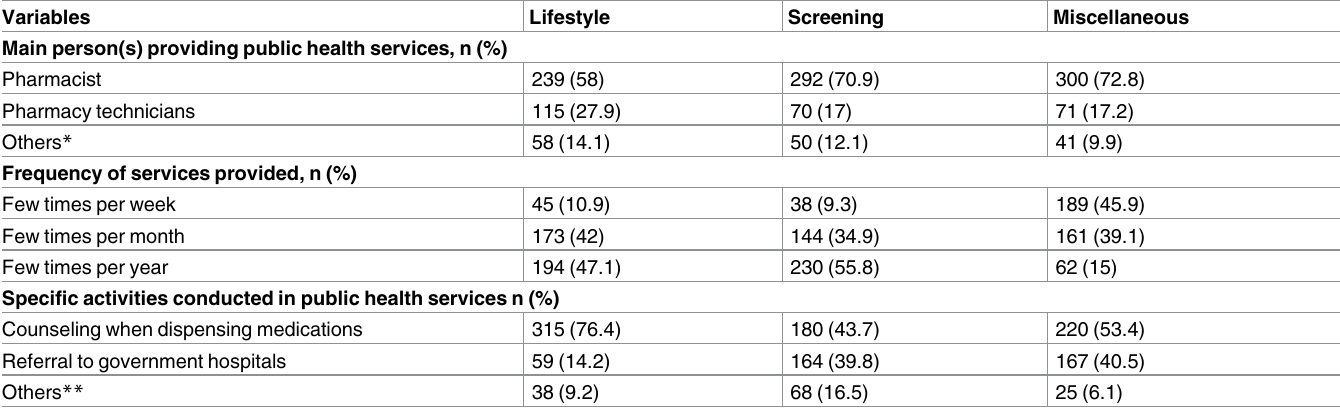
Table 3. Characteristics of public health servicesprovided by community pharmacy professionals, Ethiopia, N =